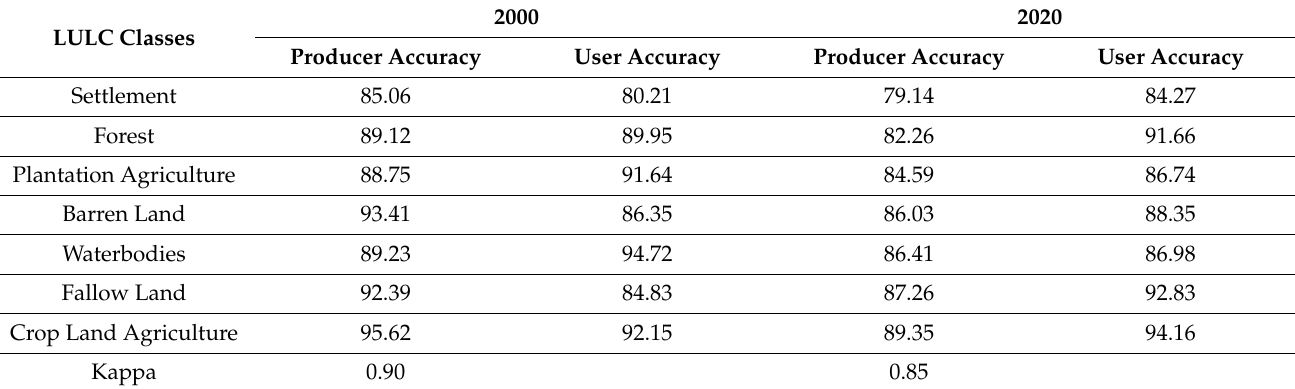
Table 4. Accuracy assessment for generated LULC